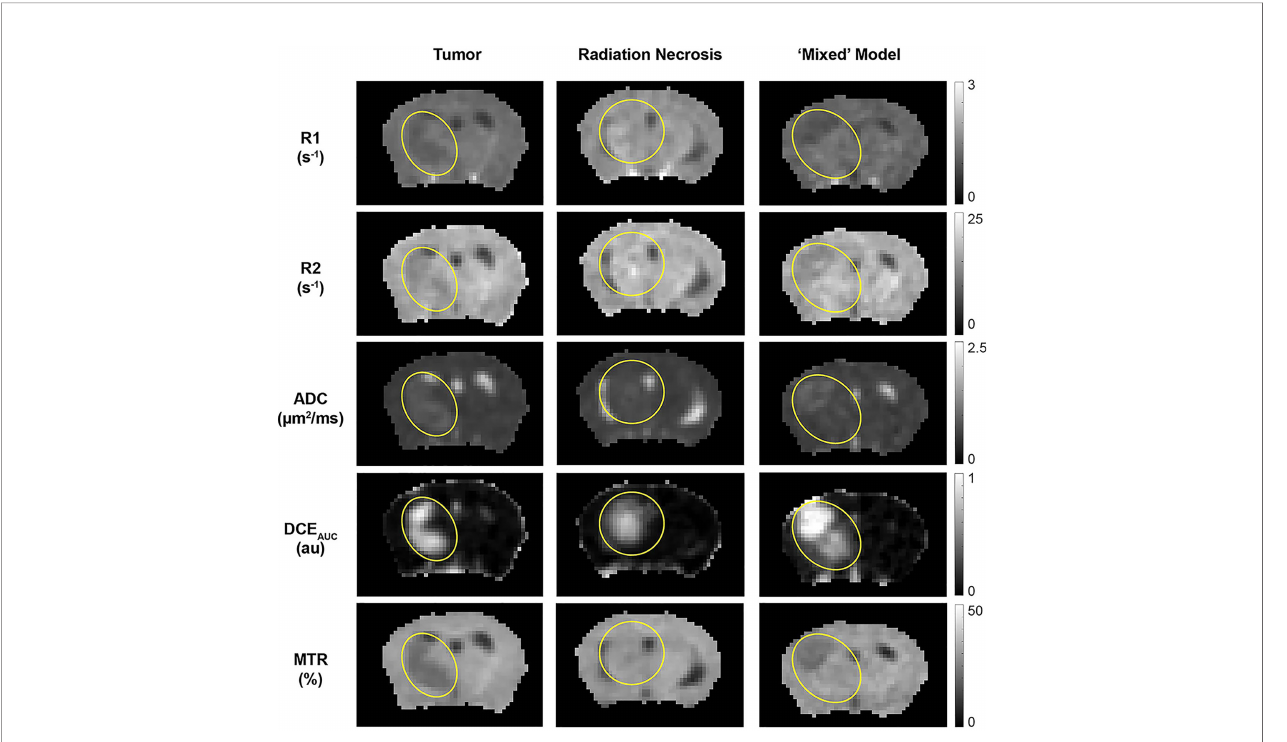
FIGURE 4 | Parametric maps, derived from the 1 H MRI pipeline of (left) pure tumor; (middle) pure radiation necrosis, and (right) mixed model. From top to bottom, maps are shown of R1 (= 1/T1), R2 (= 1/T2), apparent diffusion coef fi cient (ADC), DCE area under the curve (AUC), and magnetization transfer ratio (MTR). Yellow circles/ovals guide the eye to the locations of lesions in each of these maps.